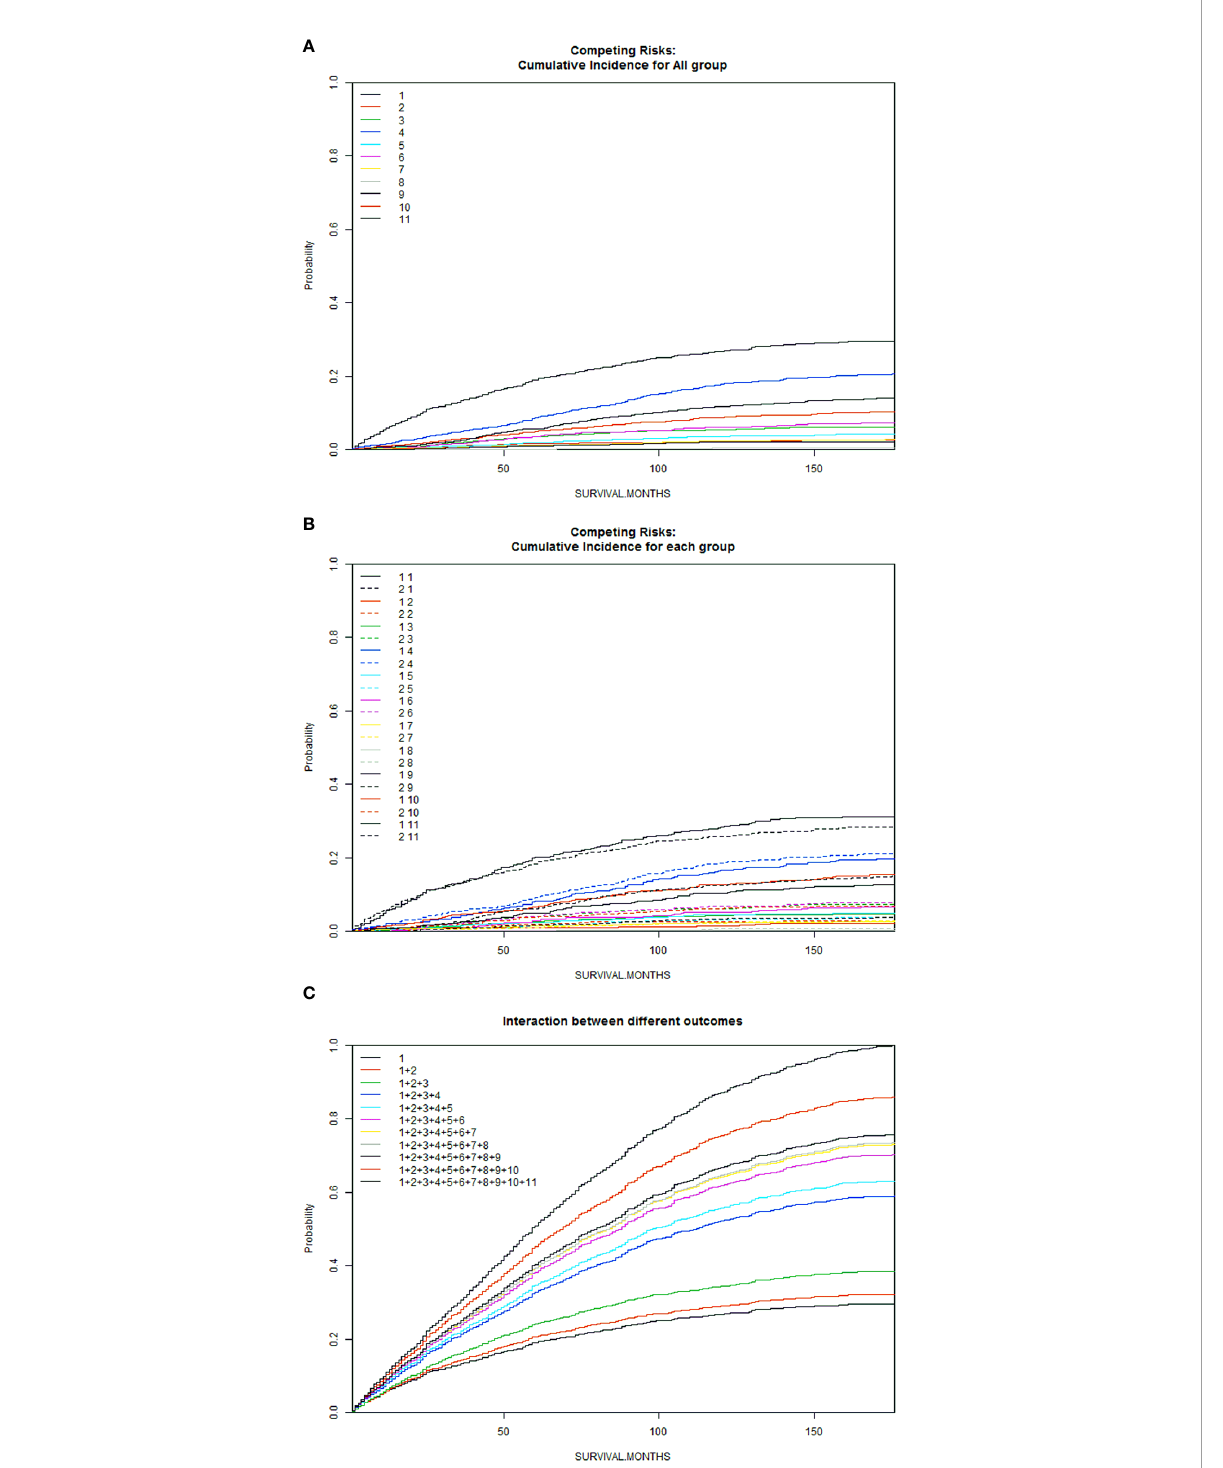
FIGURE 2 Competitive risk curves for causes of death in chRCC patients (A) : Cumulative Incidence for All Group; (B) : Cumulative Incidence for Each Group; (C) : Interaction Between Different Outcomes [Front (1: Female, 2: Male); Back (1: ChRCC; 2: Diseases of the blood system; 3: